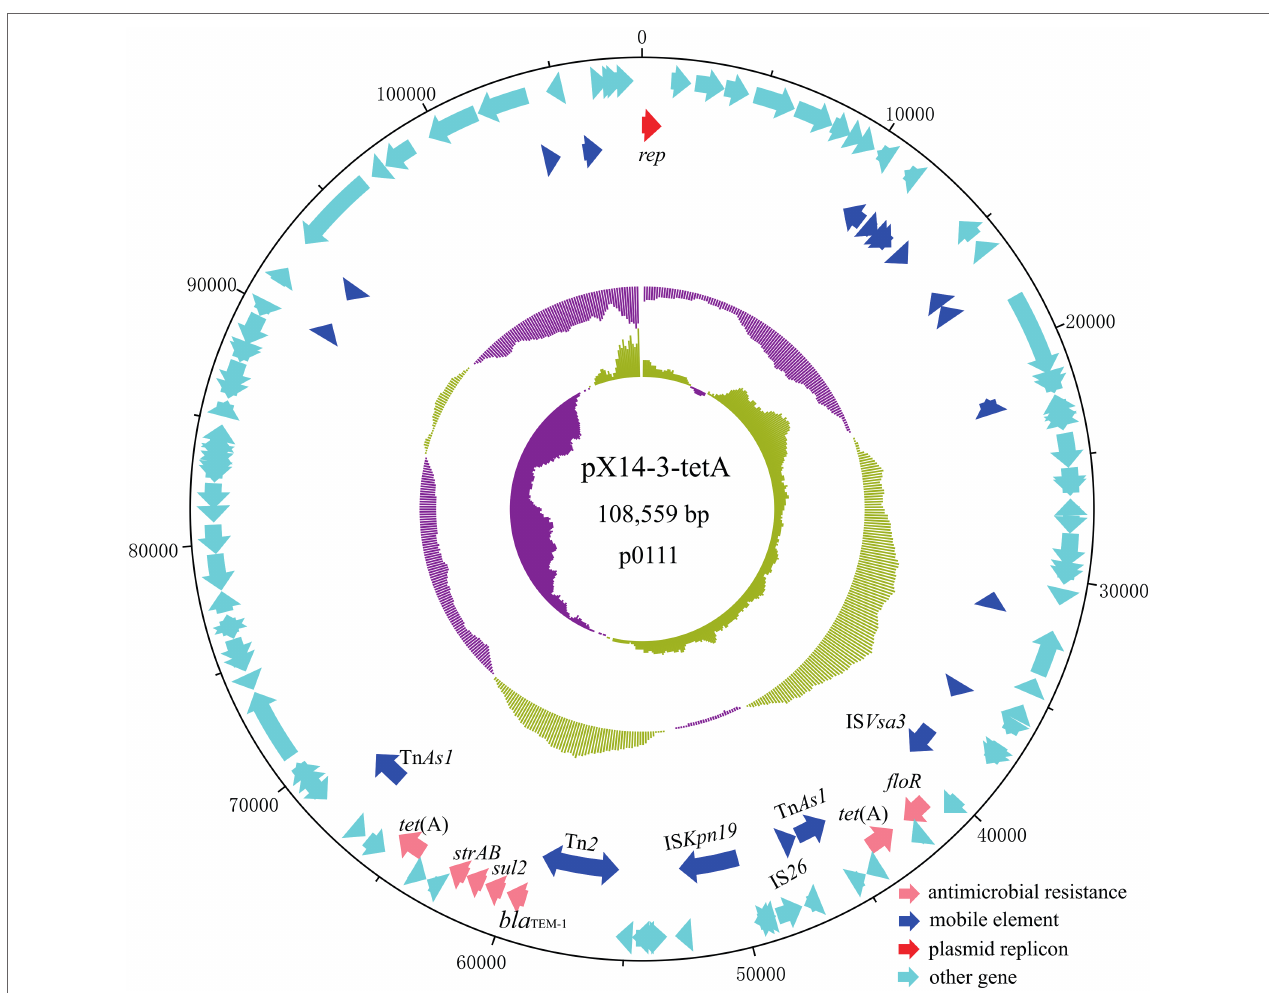
FIGURE 3 | Circular plasmid map of pX14-3-tetA. Pink, blue, red, and cyan arrows represent genes responsible for antimicrobial resistance, mobile element, plasmid replicon, and other functions,